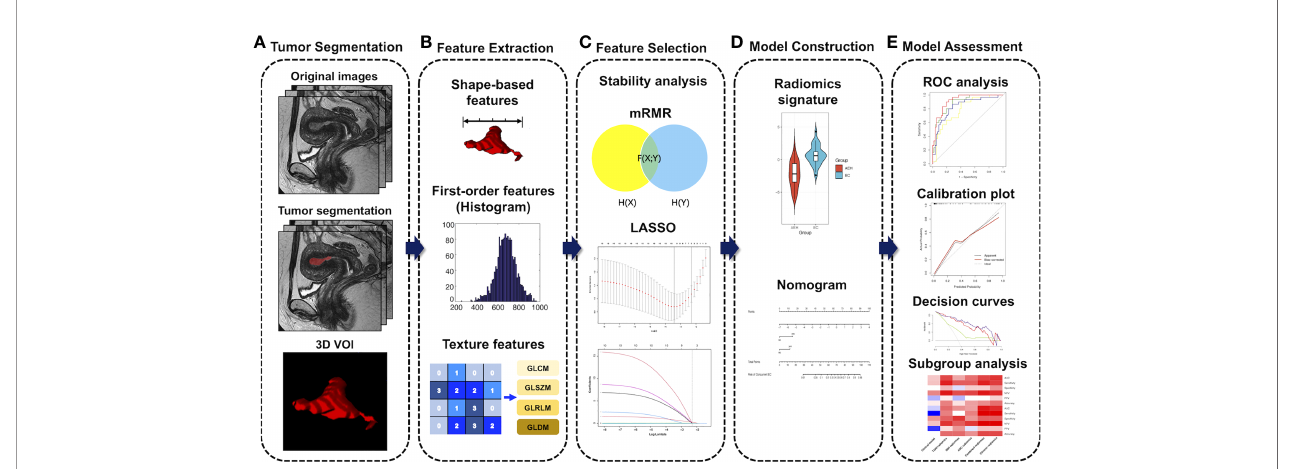
FIGURE 2 | Work fl ow of radiomic analysis. (A) MR imaging segmentation. Three-dimensional (3D) segmentation of tumors in MR images. (B) Radiomic feature extraction. Radiomic features, including shape, intensity, and texture, were extracted from the tumor volume. (C) Feature selection process. The stability analysis, the minimum redundancy maximum relevance (mRMR), and the least absolute shrinkage and selection operator (LASSO) algorithm were used for the radiomic feature selection. (D) Model construction. Radiomics signatures were constructed using a binary logistic regression model. Finally, a nomogram for the optimal model was developed. (E) Model assessment. The performances of our models were evaluated by discrimination, calibration, and clinical utility, as well as subgroup analysis. VOI, volume of interest; GLCM, gray level co-occurrence matrix; GLSZM, gray level size zone matrix; GLRLM, gray level run length matrix; GLDM, gray level dependence